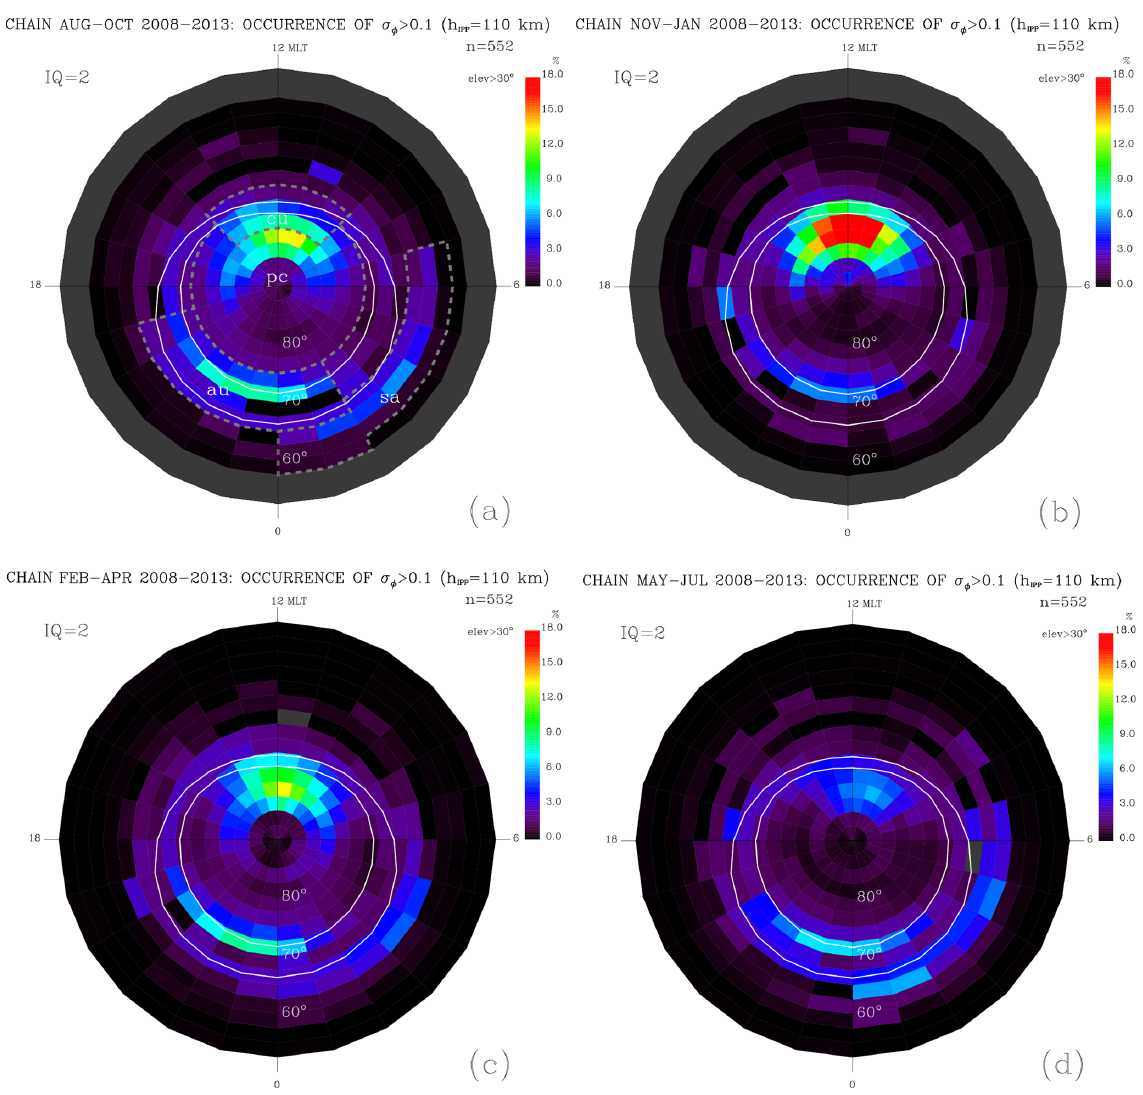
Figure 5. Phase scintillation occurrence maps ( h IPP = 110km) for (a) autumn, (b) winter, (c) spring and (d)